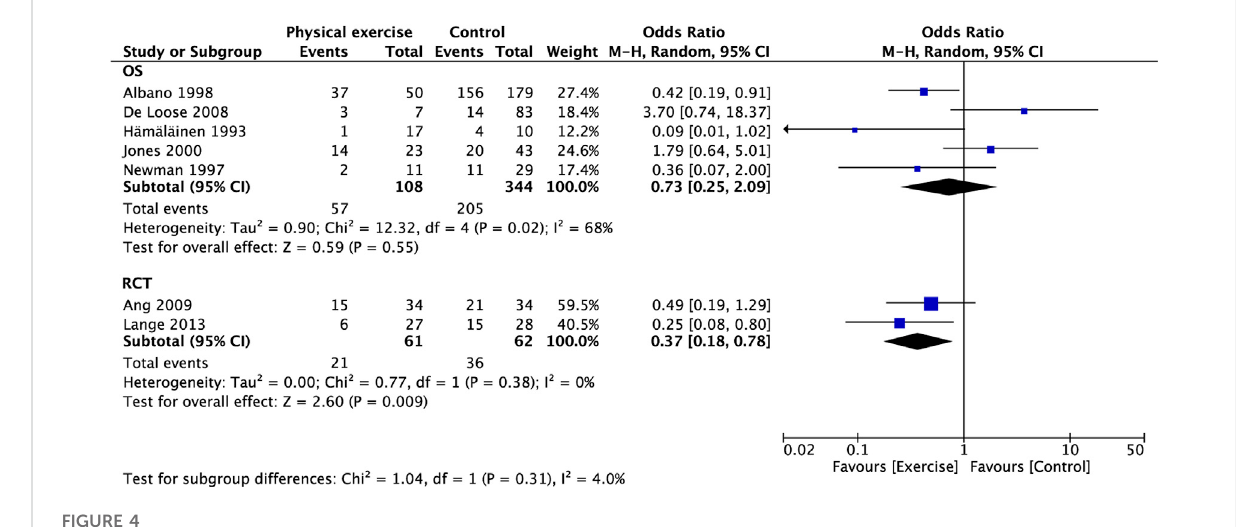
FIGURE 4 Subgroup analysis for prevalence of neck pain (type of study).